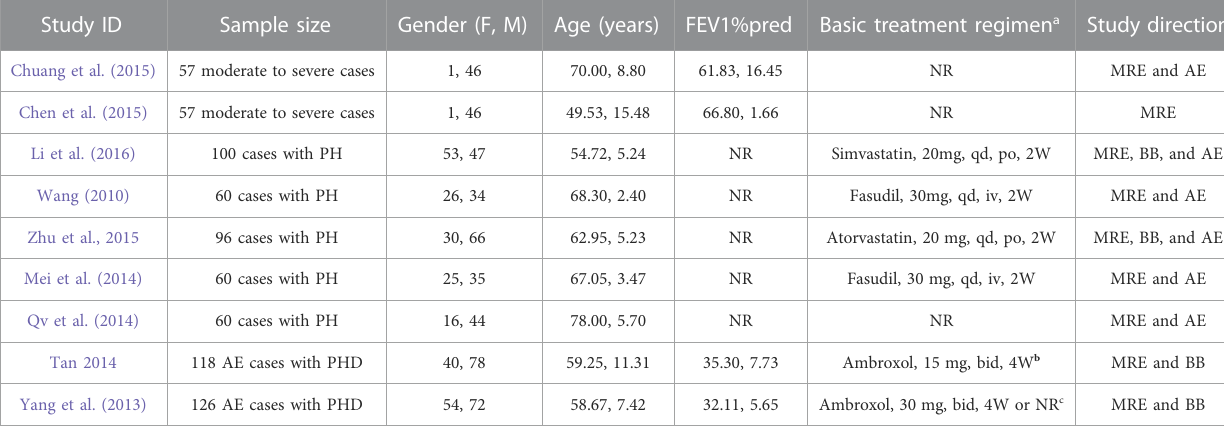
TABLE 1 Basic characteristics of included